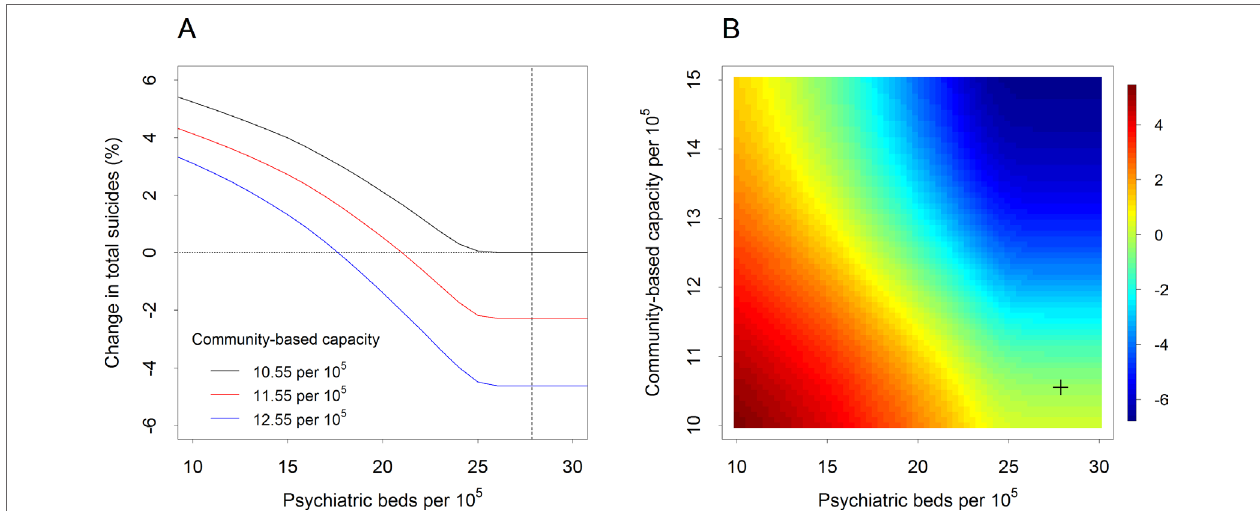
FIGURE 1 | Impact of changes in psychiatric bed availability and community-based mental health service capacity on forecast percentage changes in suicide (Western Sydney, 2018–2028) * (A) Change in the total number of suicides over the period 2018–2028 compared with the baseline scenario (expressed as a percentage of the baseline total) as a function of the number of psychiatric beds per 10 5 population assuming different levels of non-secondary services capacity (i.e., numbers of community-based practitioners per 10 5 population). The dashed vertical line indicates the baseline number of psychiatric beds per 10 5 population. (B) Percentage change in the number of suicides (compared with the baseline total) as a function of secondary and non-secondary services capacity. The cross in the lower right corner indicates the baseline capacity values (27.86 psychiatric beds and 10.55 community-based practitioners per 10 5